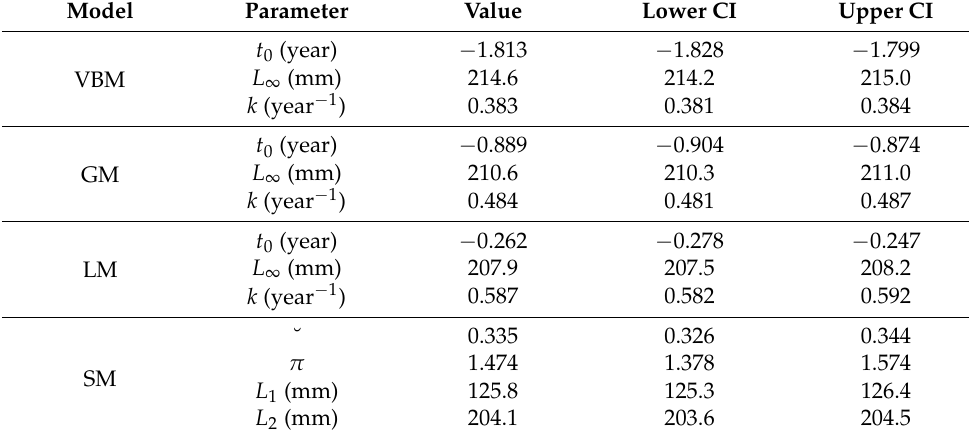
Table 6. Growth parameter values and 95% confidence intervals (CI; α = 0.05) estimated by models model), fitted to raw age–length data bolstered by simulated values of the temperate Sardinops sagax stock in the southern California Current System (CCS) during the study period (2005–2014).